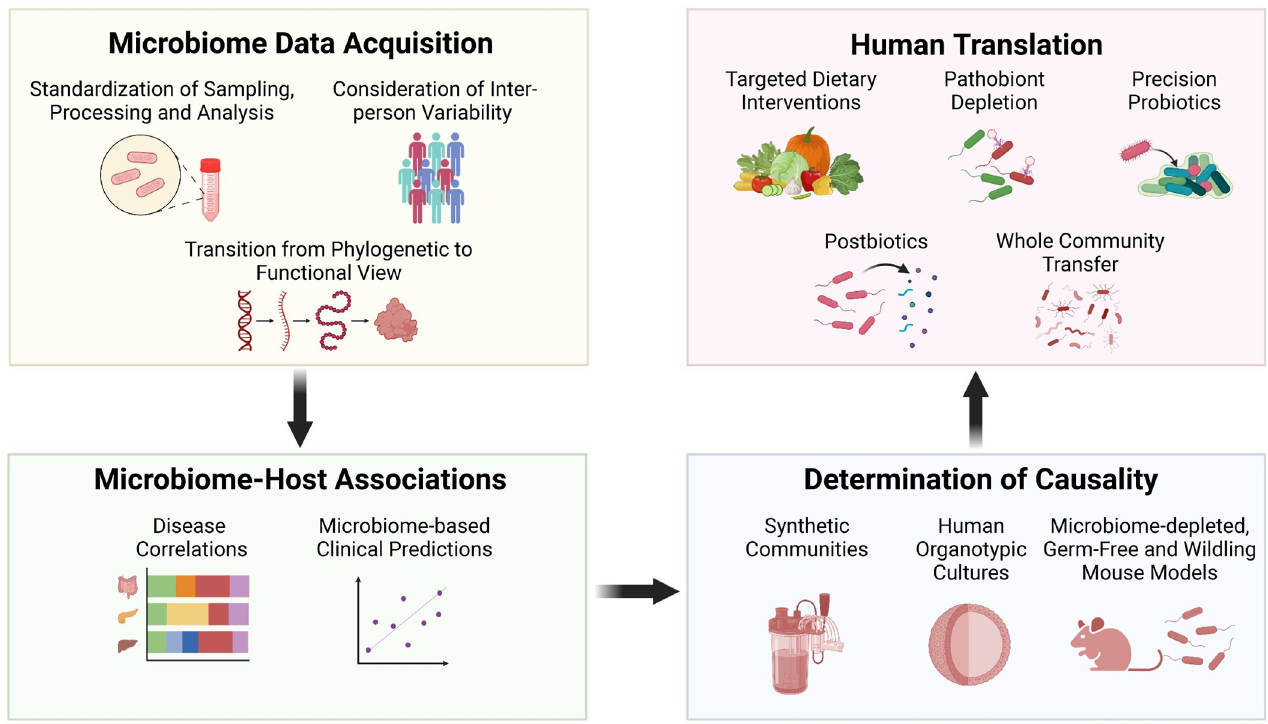
Fig 1. Challenges and emerging approaches in microbiome research. In meeting the formidable challenges that have complicated top-down microbiome research in the past 2 decades, the maturing field is increasingly searching for means of enhancing standardization of microbiome data acquisition and analysis, and diversifying microbiome characterization through incorporation of a variety of genomic and nongenomic pipelines, while accounting for potential confounders, caveats, and interindividual variability. The maturing field is increasingly evolving from descriptive research that highlights associations, correlations, and predictions, into mechanistic exploration of causality and molecular insights. These, coupled with enhanced usage of “big data” analytics, enable the development of personalized diagnostics and precision microbiome interventions. These modalities are expected to be tested in humans and would hopefully integrate into clinics in the coming decade. All these top-down approaches are complementary and pursued in parallel to each other and to bottom- up microbiome